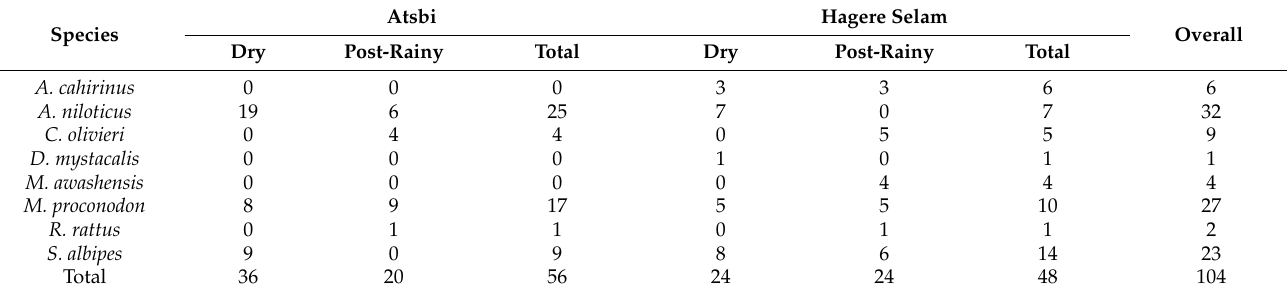
Table 3. Number of individuals captured per species in the dry and post-rainy